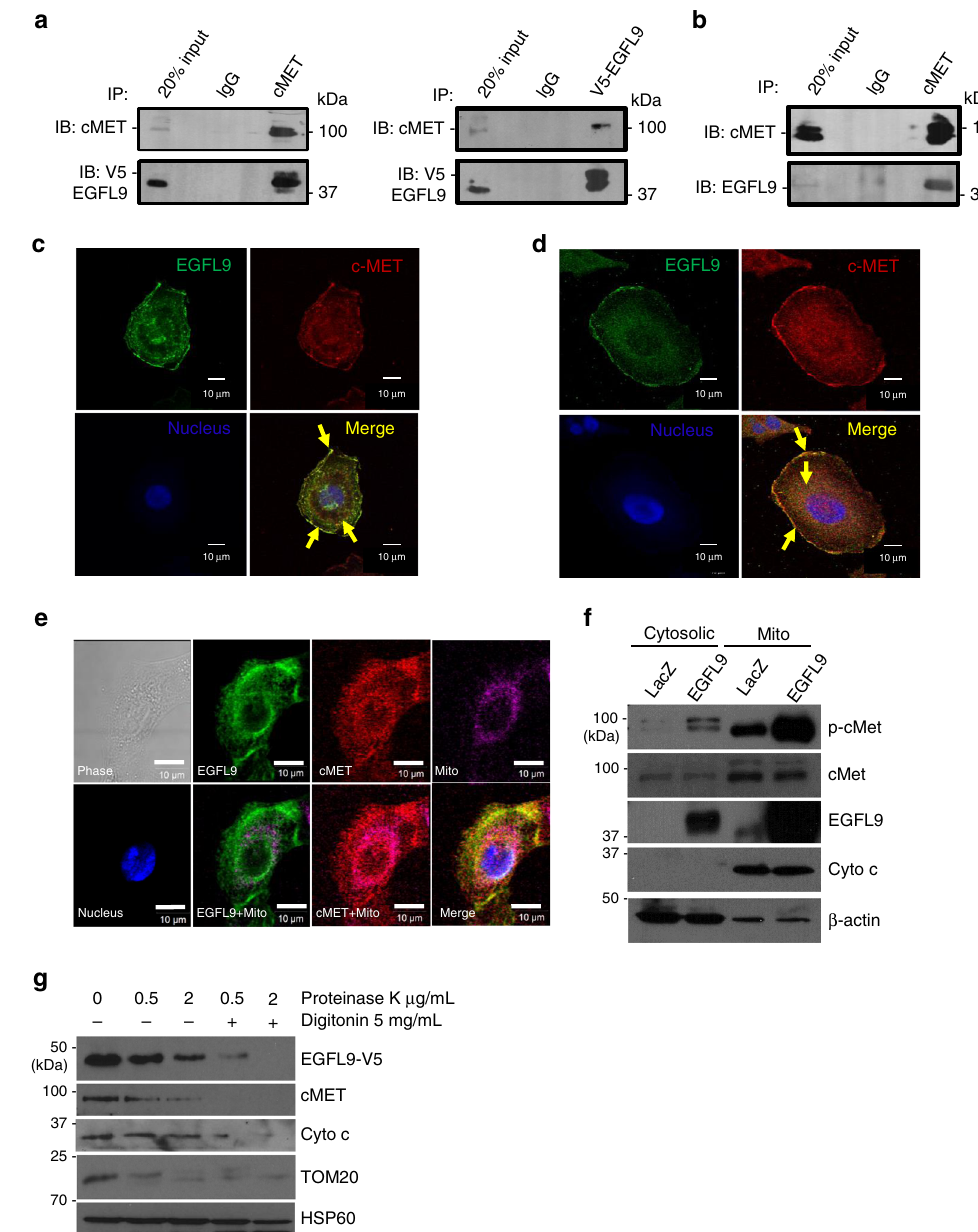
Fig. 6 Physical association and co-localization of EGFL9 and cMET. a Interaction of EGFL9 and cMET in HMLE/EGFL9 cells. Left panel: immunoprecipitation was performed with anti-v5 antibody followed by immunoblotting with cMET antibody. Right panel: immunoprecipitation was performed with anti-cMET followed by immunoblotting with anti-V5 antibody. b Interaction of EGFL9 and cMET in SUM159 cells. Immunoprecipitation was performed with anti-cMET antibody followed by immunoblotting with anti-EGFL9 antibody. For both a and b , IgG was used as the IP-control. c , d Subcellular co-localization of EGFL9 and cMET in HMLE/EGFL9 ( c ) and SUM159 ( d ) cells. The distribution of ectopic expressed EGFL9 was detected with anti-v5 antibody ( c ). Endogenous EGFL9 was detected by EGFL9 antibody ( d ). cMET was detected with anti-cMET antibody ( c , d ). DAPI staining was included to visualize the cell nucleus. Scale bar: 10 µ m. e Co-localization of EGFL9 and cMET in mitochondria in HMLE/EGFL9 cells. Mitochondria were stained with Mitotracker deep-red dye. The distribution of ectopic expressed EGFL9 was detected with an anti-V5 antibody. cMET was detected with an anti-cMET antibody. DAPI staining was included to visualize the cell nucleus. Scale bar: 10 µ m. f Cytosolic and mitochondrial fractions were isolated from HMLE/EGFL9 cells and subjected to SDS- PAGE followed by probing with speci fi c antibodies as indicated. Cyt c , mitochondrial marker; β -actin, cytosolic marker. g Proteinase K protection assay. Equal amounts of puri fi ed mitochondria were treated as indicated. Lysed protein was separated by SDS-PAGE and immunoblotted using the indicated